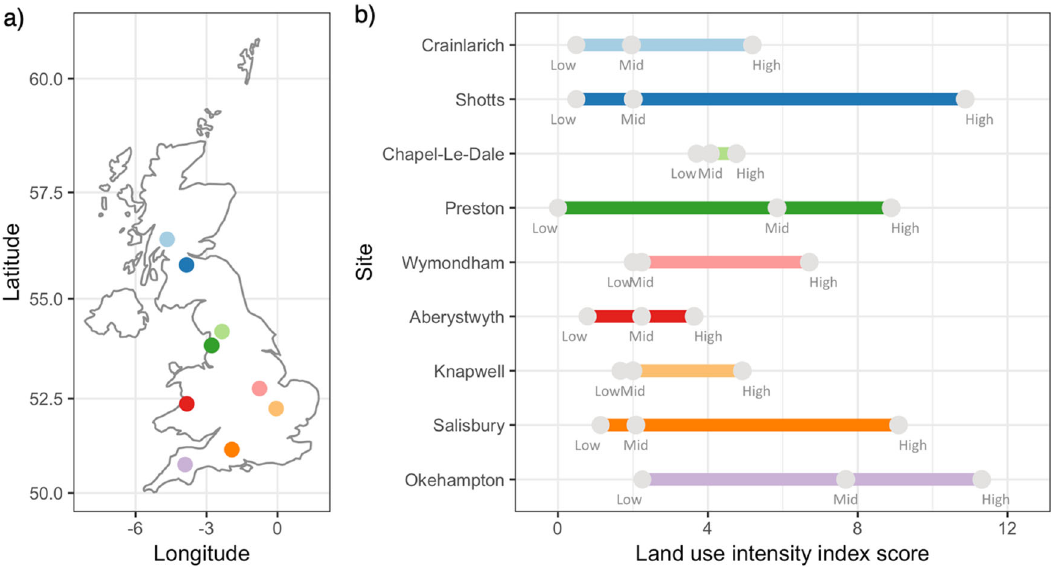
Fig. 2 The location and land use intensity (LUI) scores for the nine UK agricultural grasslands in this study. Locations ( a ) were selected to span a range of climate and soil properties. LUI scores ( b ) are derived from an additive, unweighted LUI index which compiles energy inputs (mowing, grazing, tillage and fertilizer-N additions), averaged over the past 10 years. See “ Methods ” section for